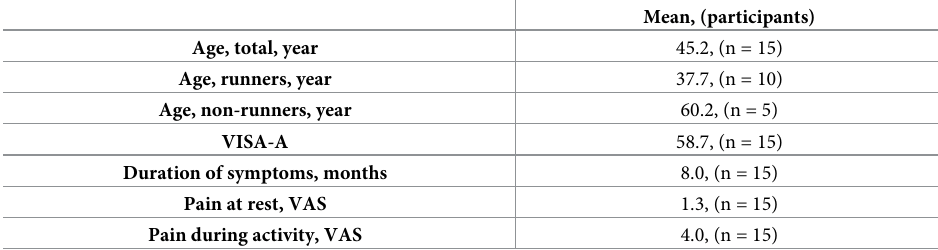
Table 2. Demographic, subjective, and objective data